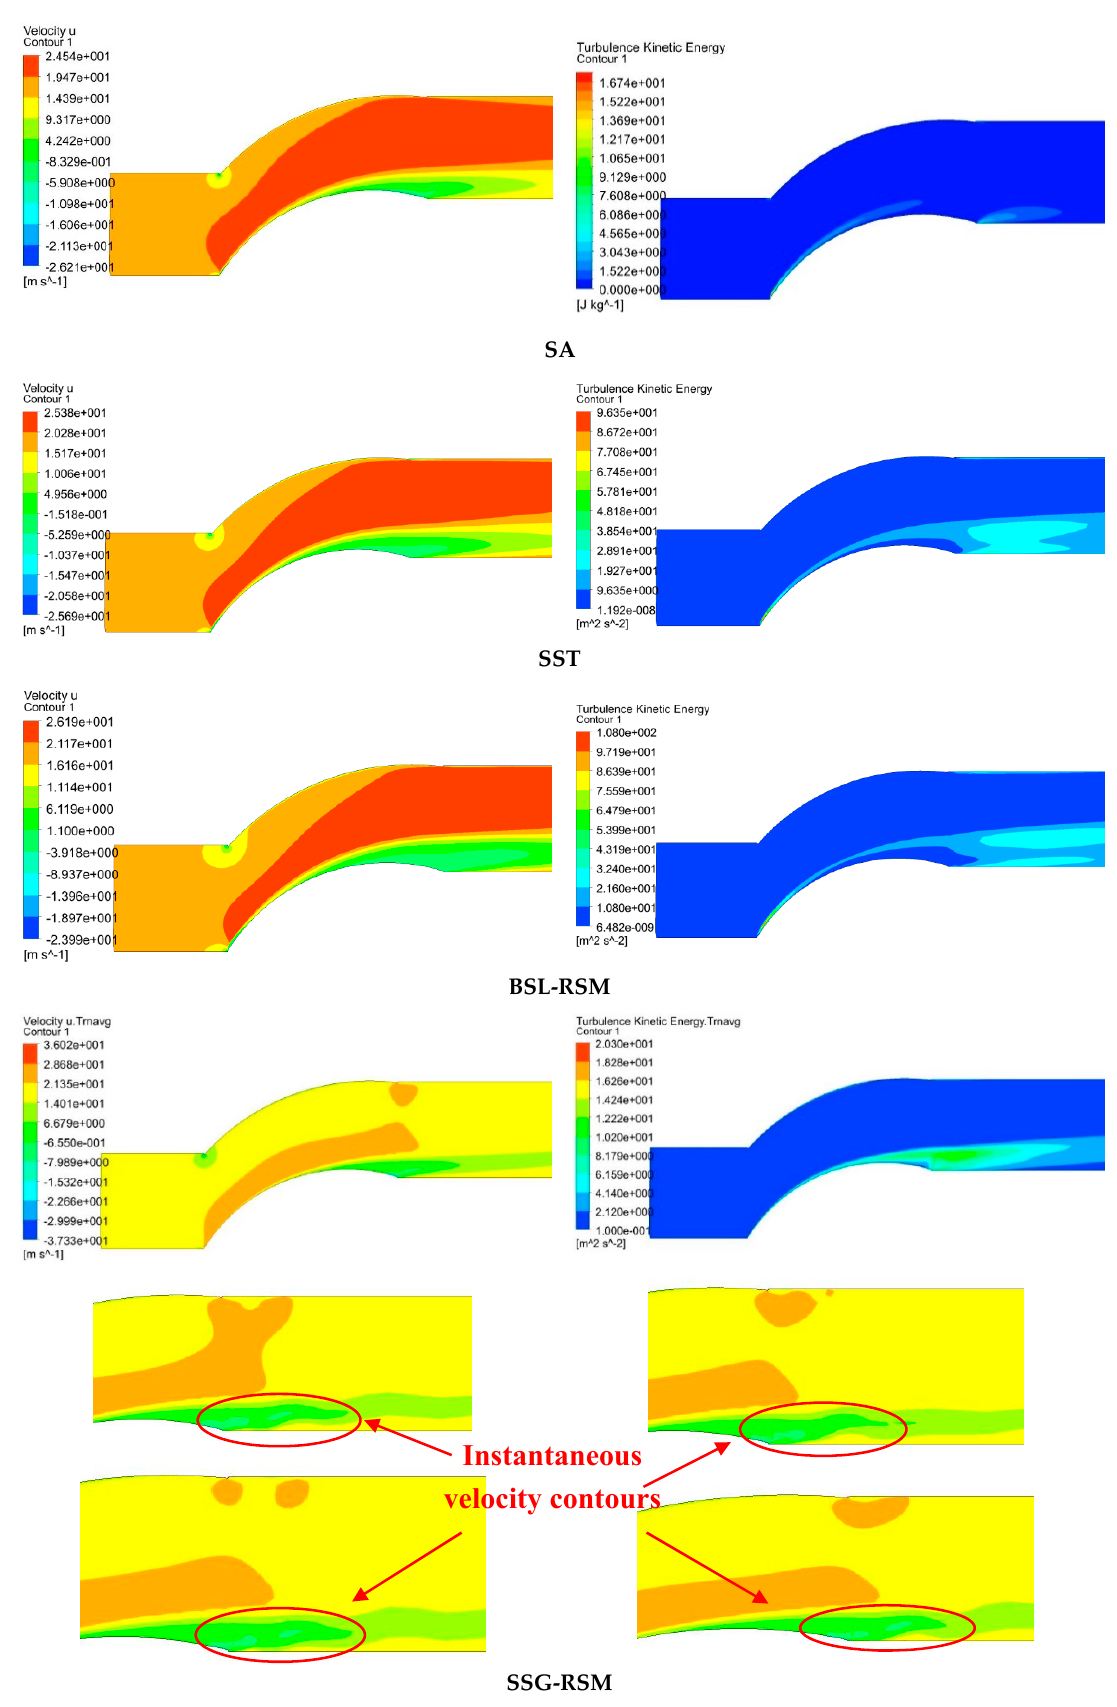
Figure 12. Velocity (averaged and instantaneous) and turbulence kinetic energy contours for all the adopted turbulence models.